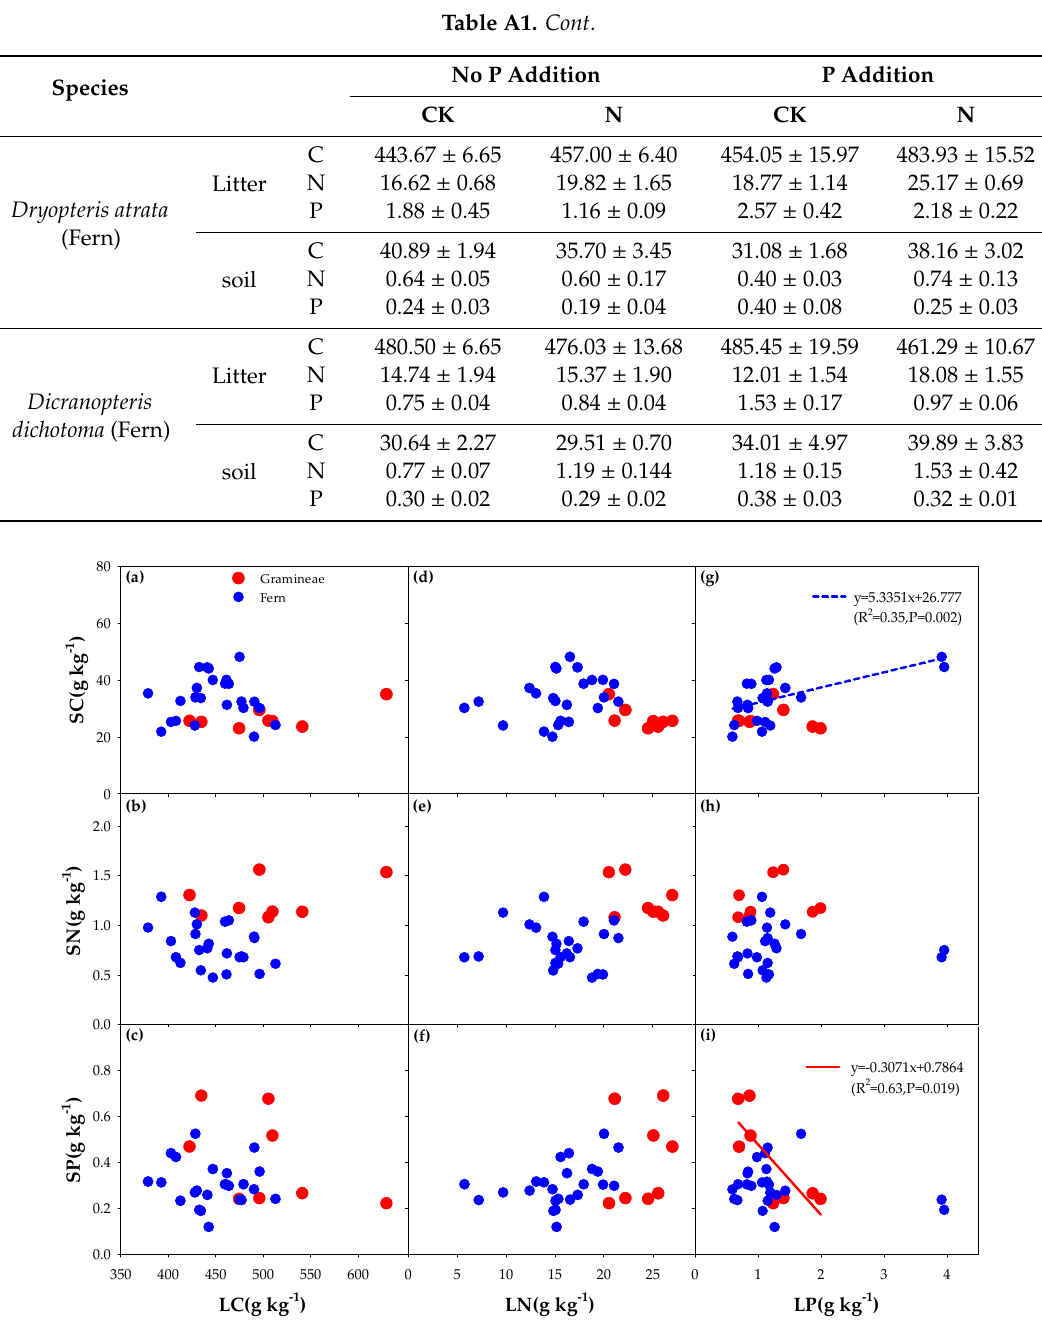
Figure A1. Correlations between litter and soil C, N and P of four dominate species with two different functional types (Gramineae Lophatherum gracile and fern Woodwardia japonica , Dryopteris atrata and Dicranopteris dichotoma ) in CK treatment.